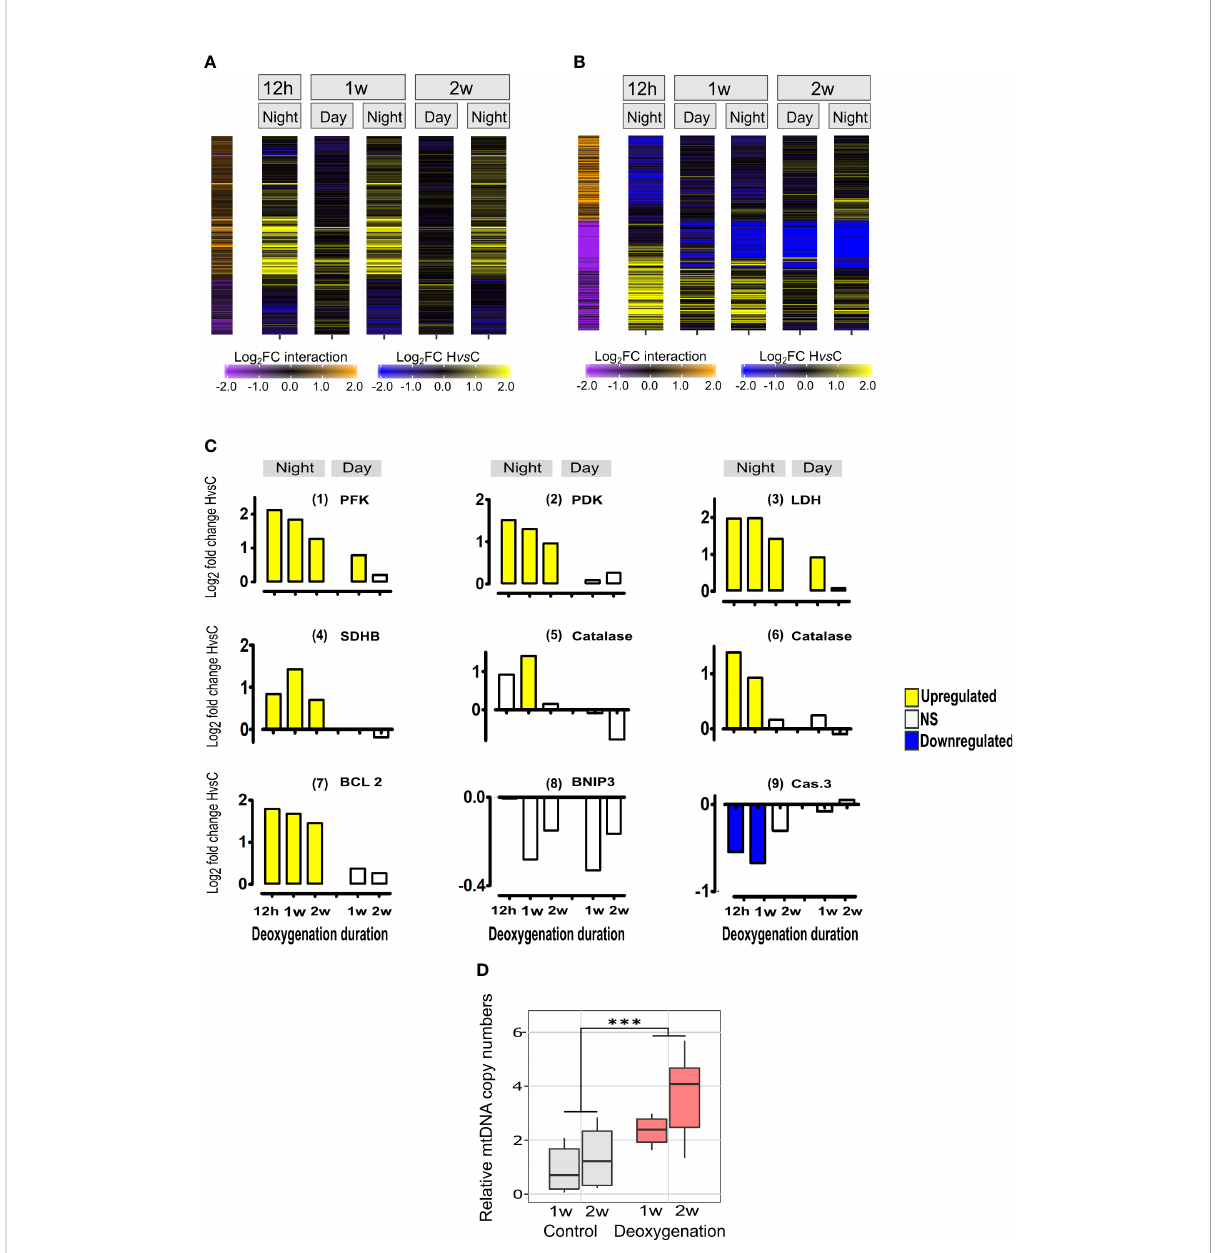
FIGURE 3 Diurnal-dependent and time-dependent changes of the transcriptional response to deoxygenation in S. pistillata and mitochondria DNA copy numbers. (A) Heatmap representing genes exhibiting diurnal-dependent changes of the intensity of response to deoxygenation. For each time point, log 2 fold change of expression differences between H vs C are color-coded as blue-black-yellow gradient. Represented genes that have signi fi cant H vs C x Day vs Night interactions using DESeq2 are color-coded in orange-black-purple scale shown on the left-side of the heatmap. Interaction log 2 FC values are color-coded as yellow-black-blue gradient. Log 2 FC values lower than -2 or higher than 2 are color-coded as maximum values (Data S1 and Table 1). (B) Heatmap representing genes exhibiting time-dependent changes of the intensity of response to deoxygenation. Details are as in part A of this fi gure and represented genes that have signi fi cant H vs C x Time interactions using DESeq2 (Data S1 and Table 2). (C) Expression of orthologs of major genes: (1) Phosphofructokinase (PFK) (gene24349); (2) Pyruvate dehydrogenase kinase (PDK ) (gene21622); (3) Lactate dehydrogenase (LDH) (gene17088);(4) Succinate dehydrogenase [ubiquinone] iron-sulfur subunit, mitochondrial (SDHB) (gene 10554); (5),(6) Catalases, (gene 3500 and gene 18116, respectively); (7) anti-apoptosis styBCL2 (Kvitt et al., 2016) (gene22055); (8); Mitopagy inducing BCL2/adenovirus E1B 19 kDa protein-interacting protein 3 (BNIP3) (gene5649); (9) executioner of apoptosis styCaspase3 (Casp3) (Kvitt et al., 2016) (gene6838). DE ( p <0.05) of H vs C response is represented as Log 2 FoldChange. NS- not signi fi cant. (D) Quantitative analysis of mitochondrial Cox1 gene DNA normalized to nuclear Timeless gene DNA. Results are expressed in boxplots of independent DNA extractions from distinct fragments (n=10, one week; n=8, two weeks) incubated in control (grey) or subjected to deoxygenation (red) (see Figure S2B). Values were compared by the aligned rank transform test with signi fi cant effects for treatment (DF=1, F=20.6, p <0.0001). Asterisks indicate signi fi cant differences (Data